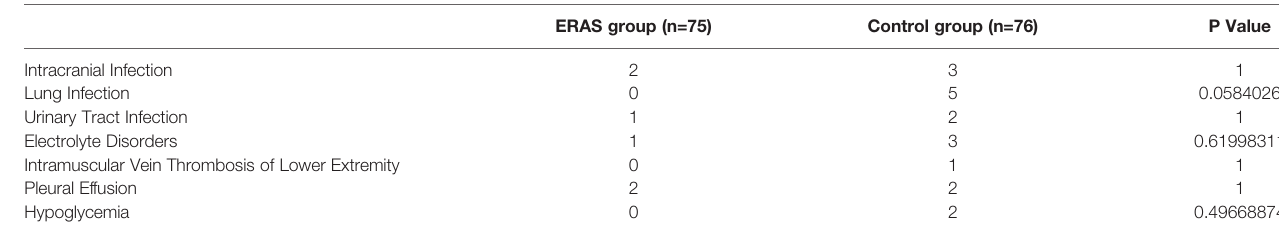
TABLE 2 | Postoperative complications in detail.